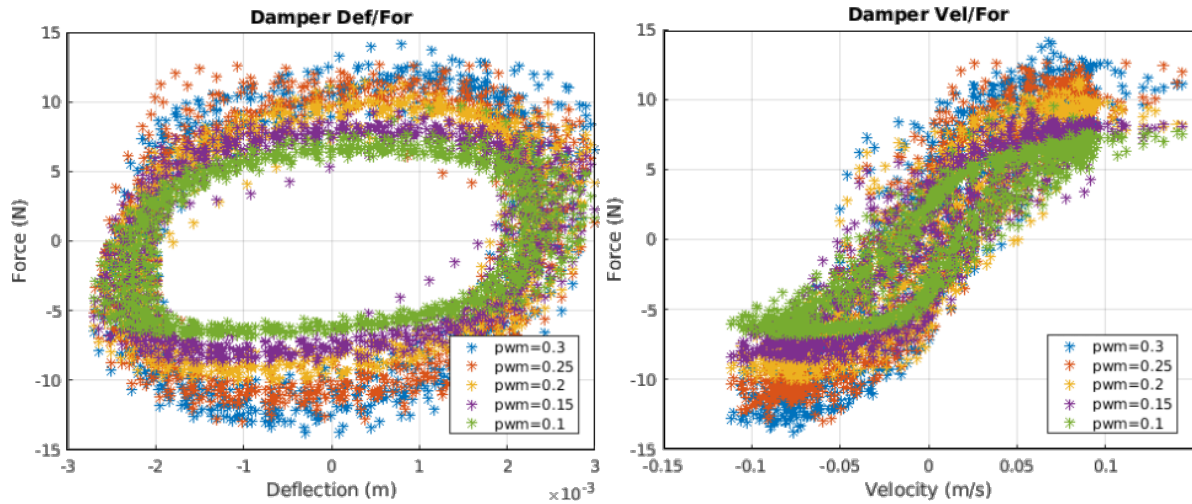
Figure 2. Force/Position ( left ) and Force/Velocity ( right ) characteristics of the ER Semi-active damper-INOVE testbed (GIPSA-lab, Grenoble).